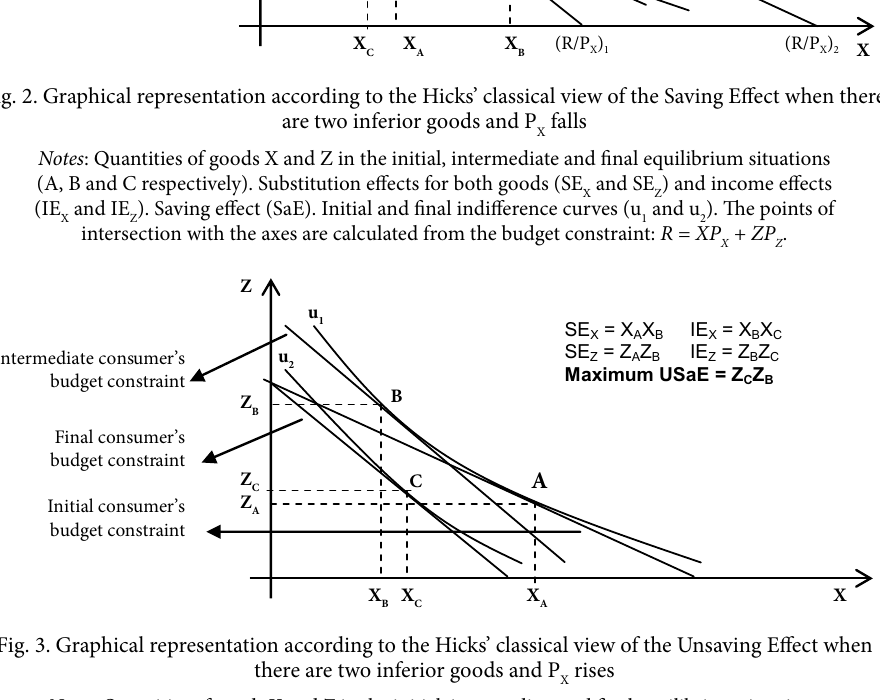
rises X and SE ) and income effects X Z and u ). 1 2 + ZP X Z